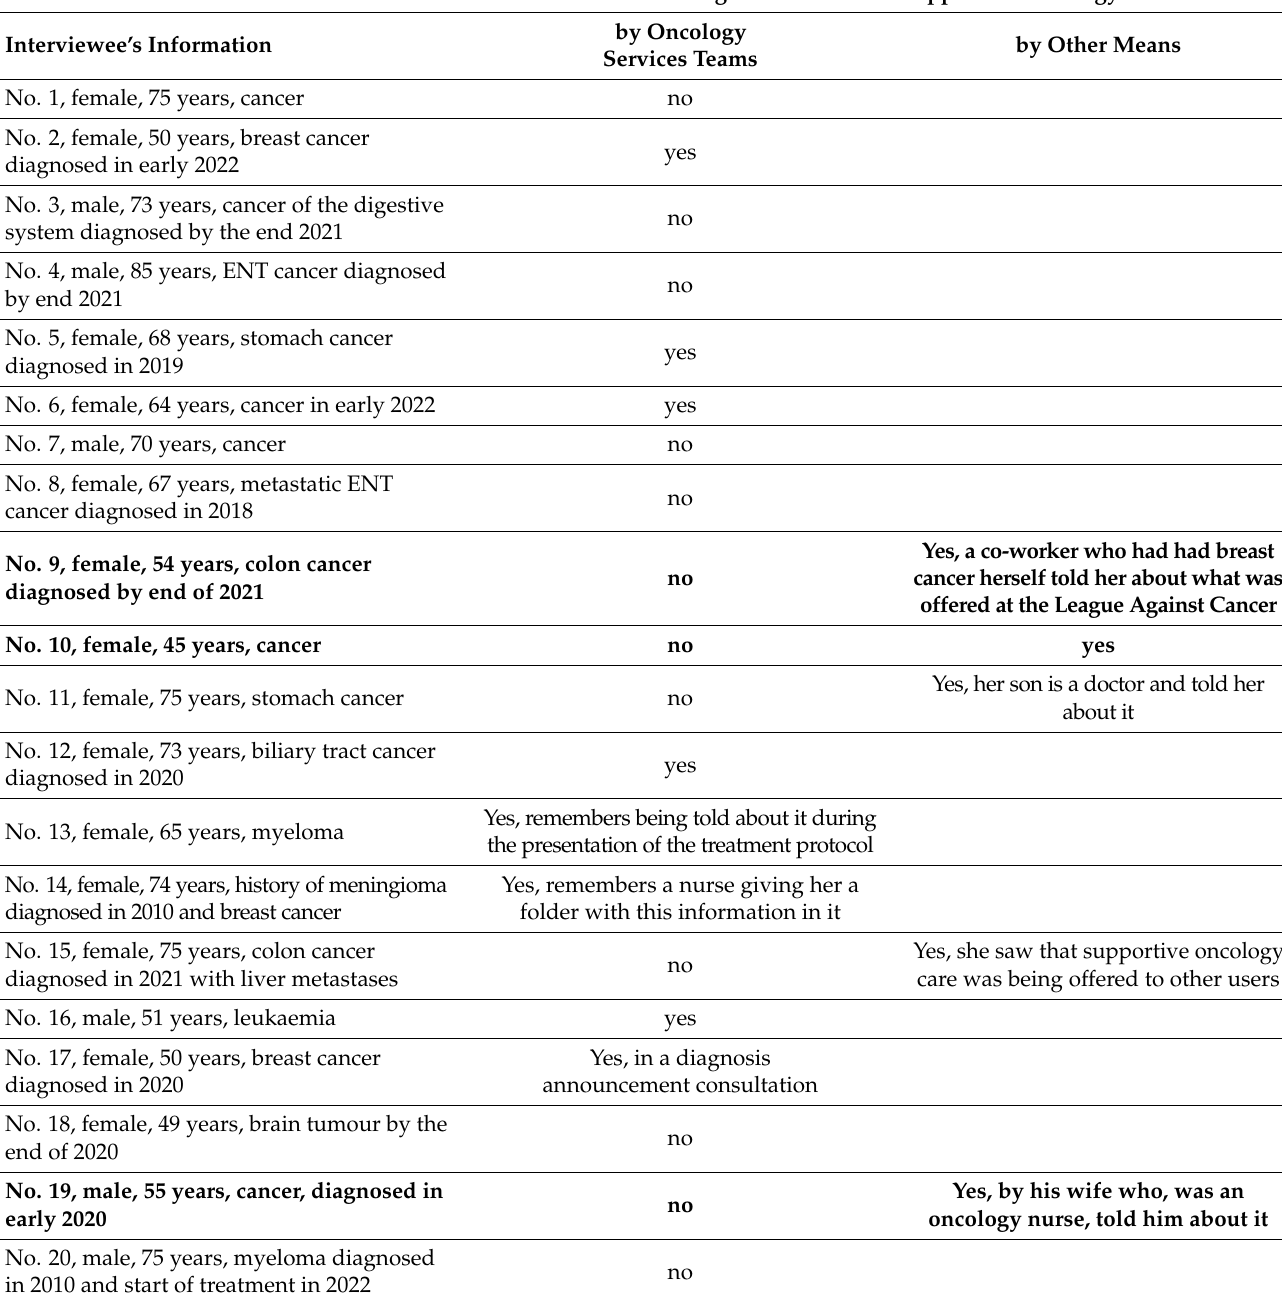
Table 1. Information on how interviewees with cancer received or did not receive information about